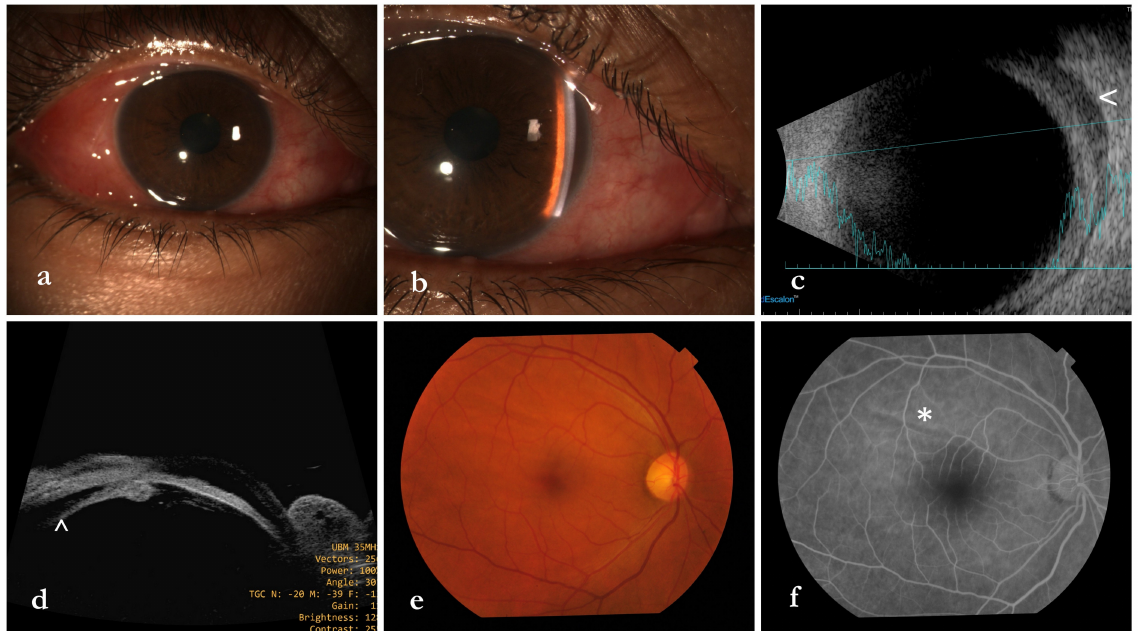
Figure 1: a,b) The slit lamp photos at presentation show the chemosis, conjunctival congestion and shallow anterior chamber with clear cornea. c) The ultrasonogram shows a thick ocular coat with subtenon fluid (<). d) The ultrasound biomicroscopy reveals supraciliary effusion (^) and anterior rotation of the ciliary body. e,f) Fundus photo and fluorescein angiogram show the choroidal folds (*).